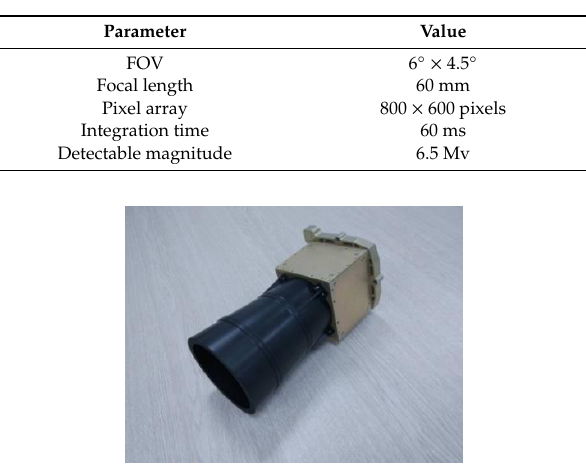
Figure 8. Star sensor in simulation.